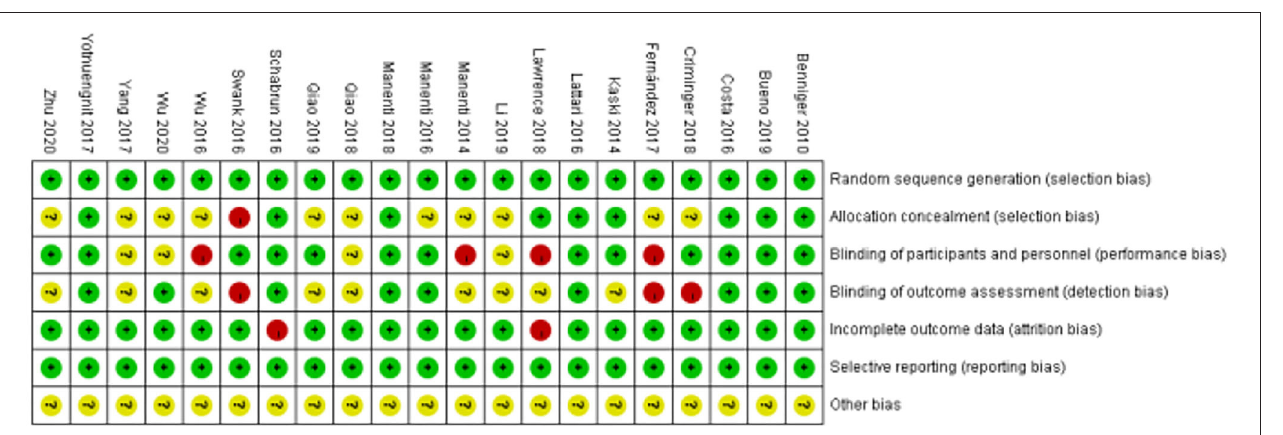
FIGURE 3 | Risk of bias summary of the included